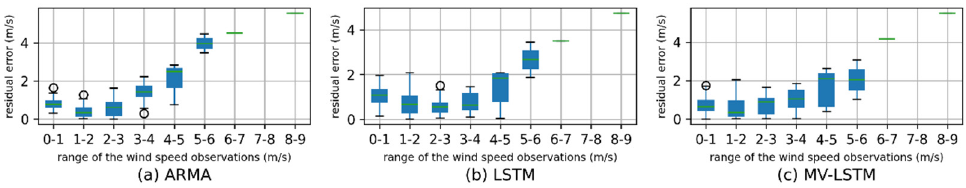
Figure 8. Boxplot of the residual errors of each method with different ranges of the wind speed on the test set of Yanqing Station.